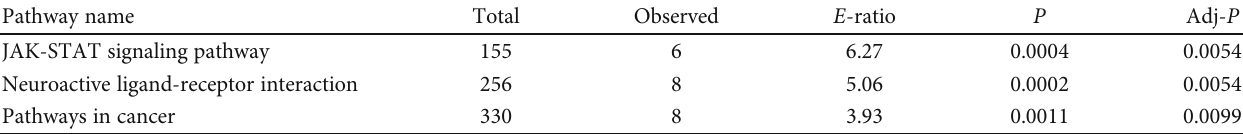
Table 4: The overrepresentation pathways identi fi ed by the top 287 genes with a P value <1 : 0 × 10 − 5 in this pooling